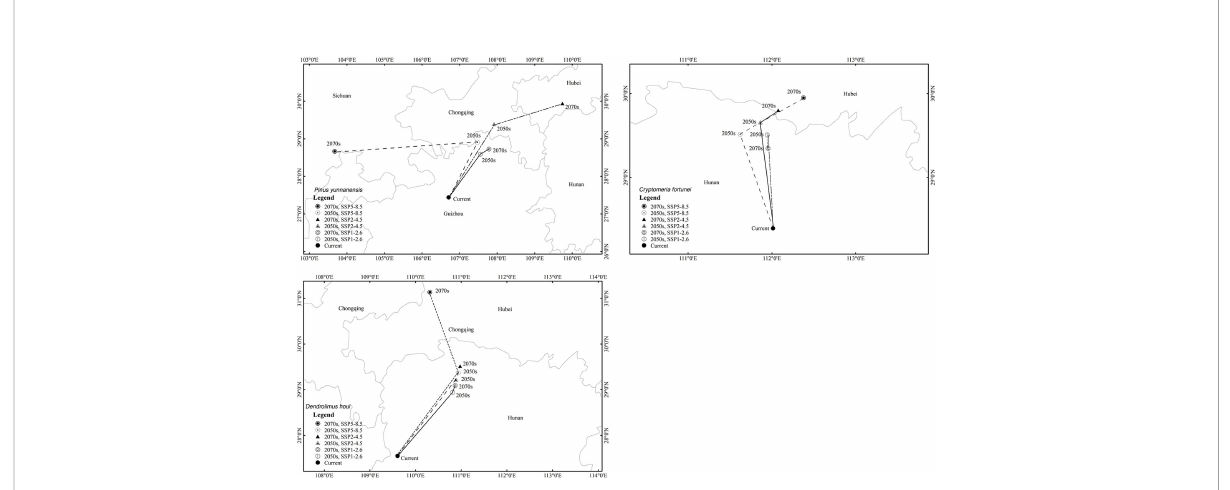
FIGURE 6 Spatial changes in the geometric centroids of suitable habitat areas by 2050 and 2070 under two different scenarios of a changing climate.